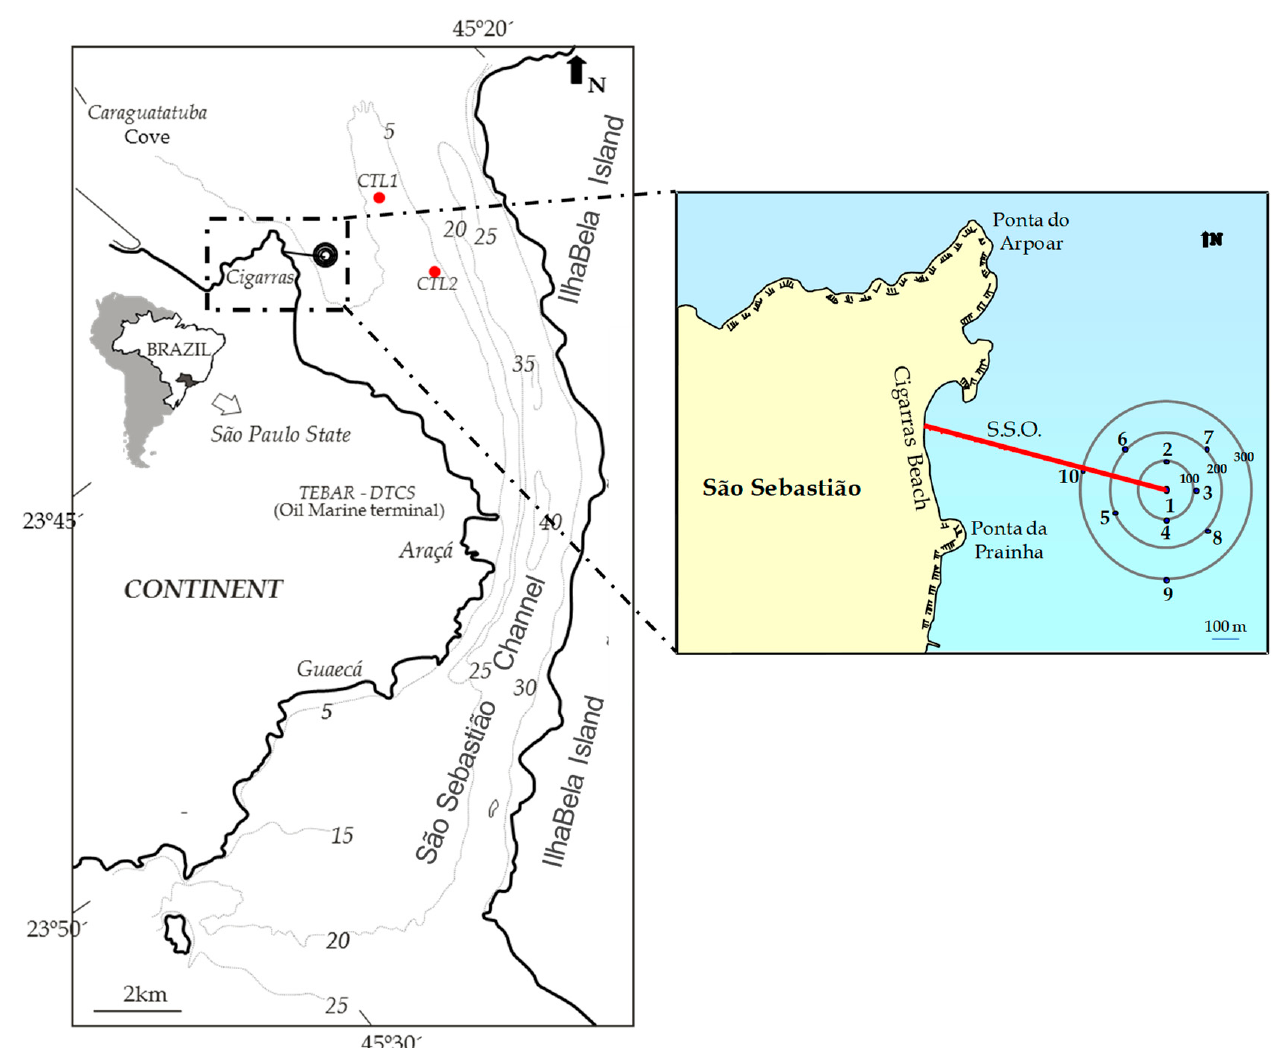
Figure 1. Study area and the analyzed station’s location near Cigarras Beach. The position of the control stations in São Sebastião Channel (CTL1 and CTL2) is also presented. Legend: S.S.O.—sewage submarine outfall.